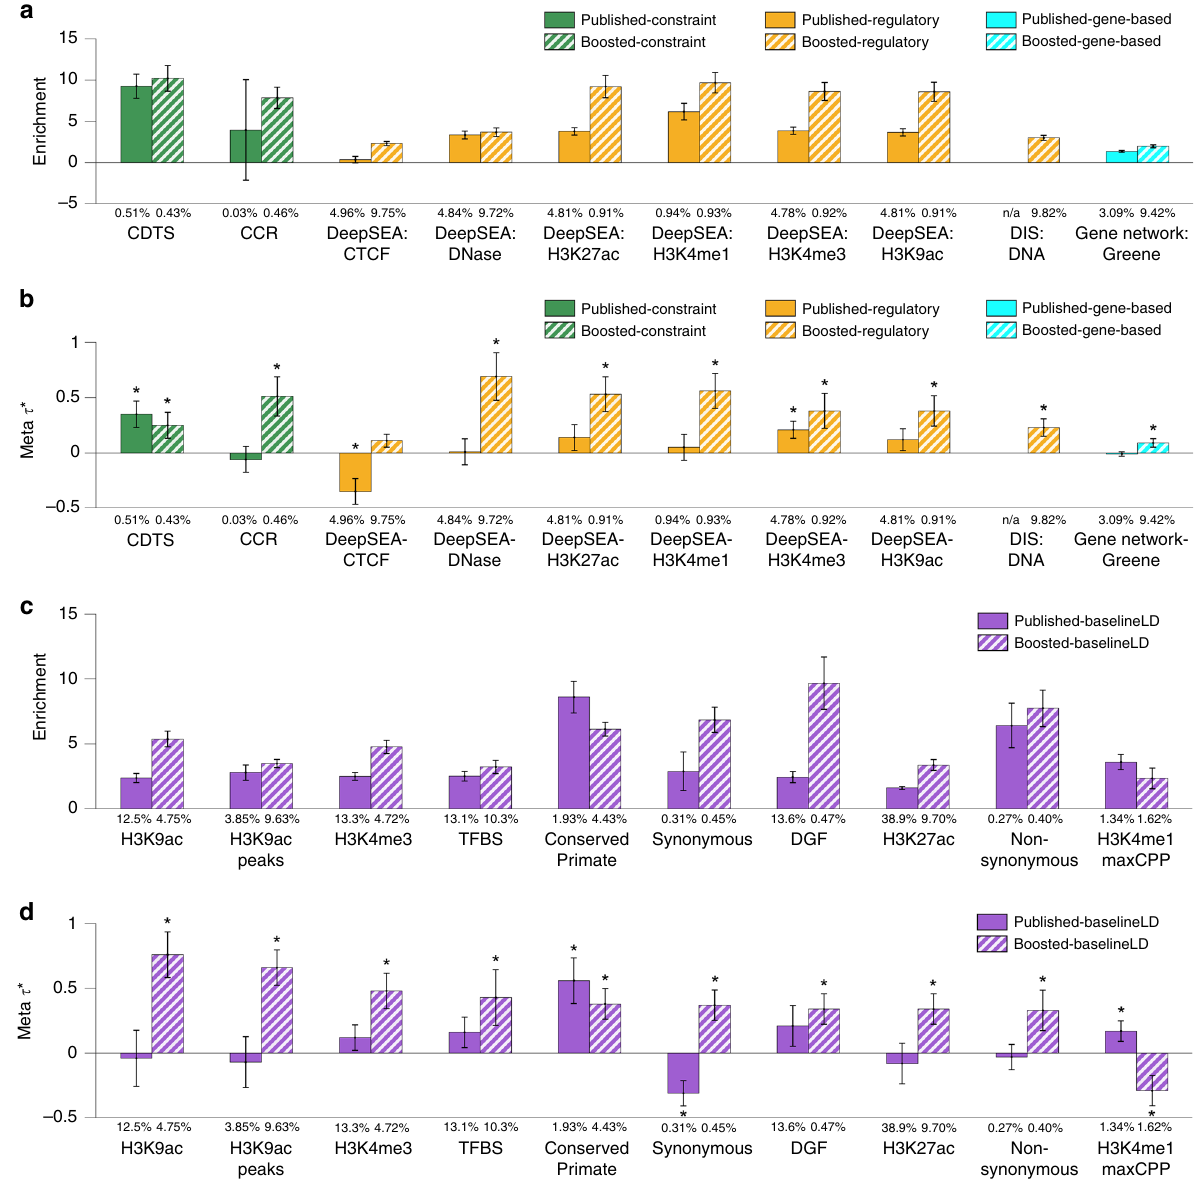
Fig. 3 Informativeness for a common disease of binary annotations derived from 18 additional genome-wide scores + 47 baseline-LD model annotations and corresponding boosted scores. We report ( a ) heritability enrichments of binary annotations derived from published and boosted additional genome-wide scores, meta-analyzed across 41 independent traits; ( b ) conditional τ * values, conditioning on the baseline-LD model and eight Roadmap annotations (for annotations derived from published scores) or the baseline-LD model, 8 Roadmap annotations, and corresponding published annotations (for annotations derived from boosted scores); ( c ) heritability enrichments of binary annotations derived from published and boosted baseline- LD model annotations; and ( d ) conditional τ * values of binary annotations derived from published and boosted baseline-LD model annotations. In ( a ) and ( b ), we report results for the 10 most informative additional genome-wide scores (of 18 analyzed). In ( c ) and ( d ), we report results for the 10 most informative baseline-LD model annotations (of 47 analyzed). The percentage under each bar denotes the proportion of SNPs in the annotation; the proportion of top SNPs included in each annotation was optimized to maximize informativeness (largest ∣ τ * ∣ among Bonferroni-signi fi cant annotations, or top 5% if no annotation was Bonferroni-signi fi cant; top 5% was the average optimized proportion among signi fi cant annotations). Error bars denote 95% con fi dence intervals. In panels ( b ) and ( d ), * denotes conditionally signi fi cant annotations. Numerical results are reported in Supplementary Data 14. Results for standardized enrichment, de fi ned as enrichment times the standard deviation of annotation value (to adjust for annotation size), are reported in Supplementary Data yielded conditionally signi fi cant binary annotations, but their τ * baseline-LD model annotation. The CCR (Constrained Coding Regions) score 48 is a constraint score based on observed vs. were small ( − 0.02 to 0.09). Boosted versions of 3 of the remaining expected variation in whole-exome sequence data; DeepSEA 5 additional scores and 20 of the remaining 23 baseline-LD model scores are described above. We note that the 18 additional scores annotations had derived binary annotations that were signi fi - included seven gene-based scores, which did not perform well; 3 cantly enriched for disease heritability (after Bonferroni correc- published gene-based scores and four boosted gene-based scores tion) but not conditionally informative (Supplementary Data 14).